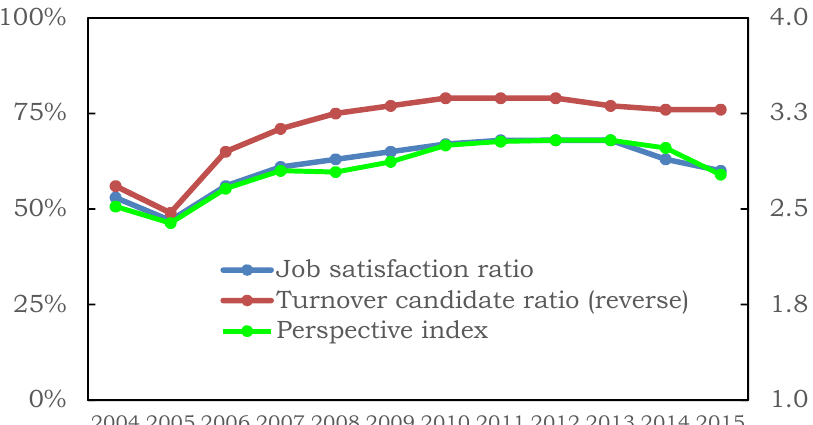
Figure 2. Annual transitions in job satisfaction ratio, turnover candidate ratio (reverse), and perspective index of Company